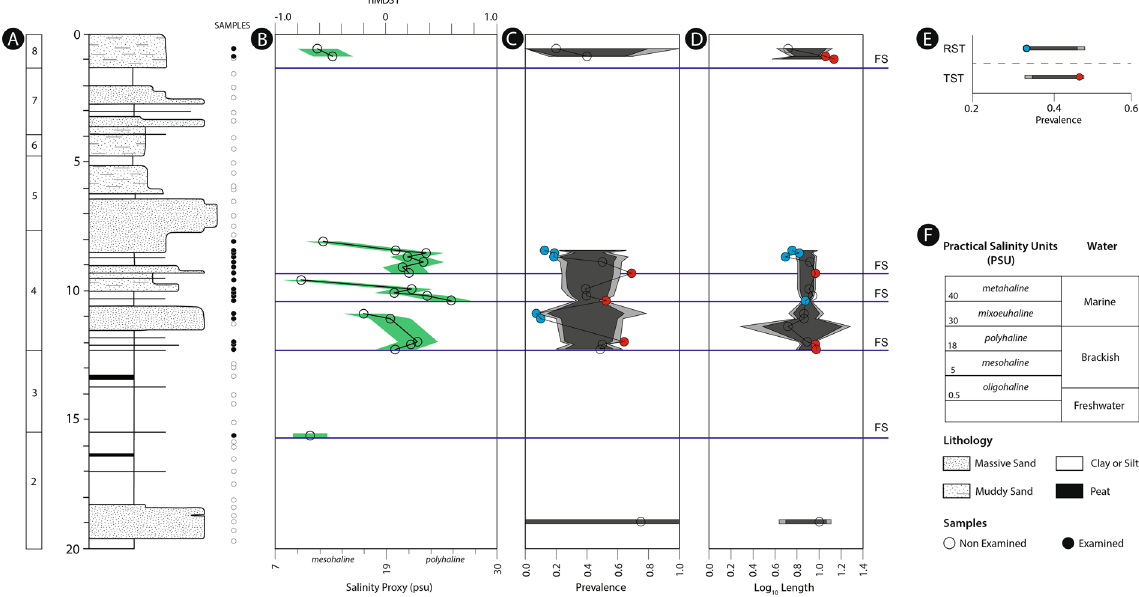
Figure 2. Detailed architectural, stratigraphic and bio-sedimentary (nMDS, A. segmentum trematode prevalence and shell length) features of core 204-S7. ( A ) Detailed stratigraphic column with 8 small-scale (millennial-scale sedimentary packages—parasequences defined in ref. 27 and the position of the studied samples: hollow circles represent samples with fewer than 15 specimens. ( B ) nMDS derived salinity trends along core highlighting back-barrier small-scale sedimentary packages and their internal architecture. Green field represents Standard Error of the Estimate (SEE) resulting from the RMA regression (see Extended Data Fig. S5) of nMDS derived salinity trends. ( C ) Prevalence of trematode pits among single samples recording more than 4 valves of Abra segmentum . ( D ) Mean log 10 -transformed anterior-posterior length of single samples of A. segmentum . ( E ) Prevalence values of data pooled by TST and RST (defined by nMDS derived trend along core). ( F ) Reference scale for Practical Salinity Units (PSU) with associated type of water and legend for lithology and samples. Dark and light grey fields on panels C, D, and E represent 95% and 99% confidence intervals (CI) derived from 10,000 iteration randomizations, respectively. Red circles indicate values greater than 95% CI, blue circles indicate values less than 95% CI, and hollow circles (in panels C and D) indicate values that fall within 95% CI. FS indicates back barrier correlative of flooding surfaces; nMDS: non Metric Multidimensional